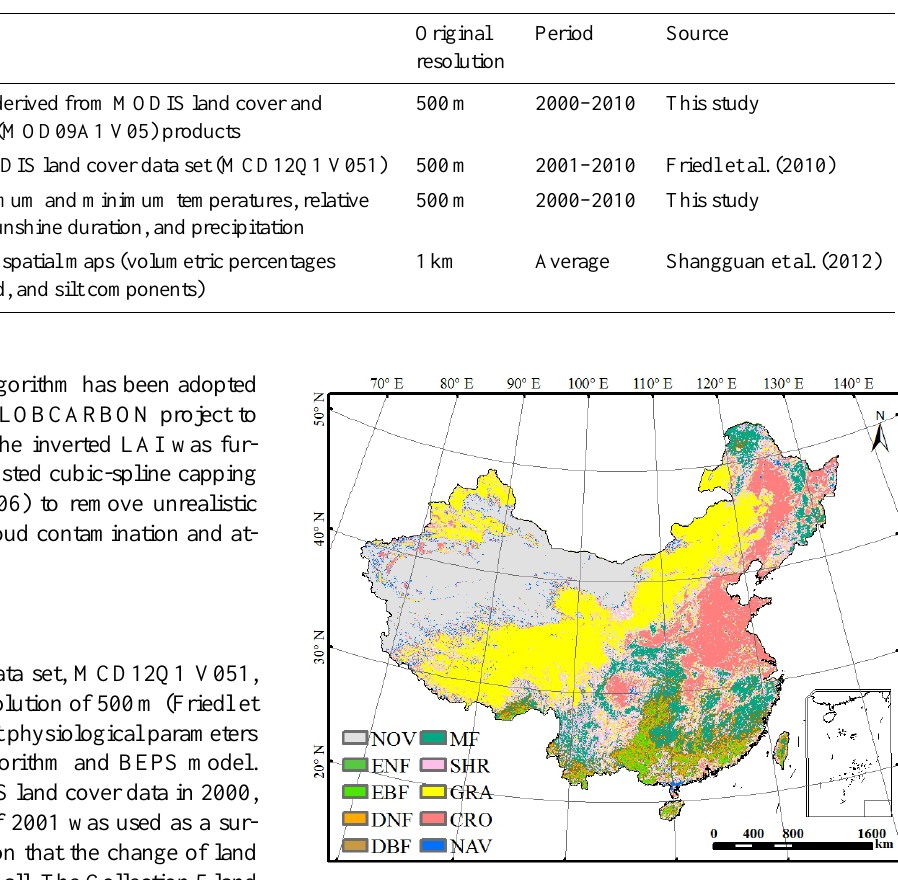
Table 1. BEPS input data sets and their description.